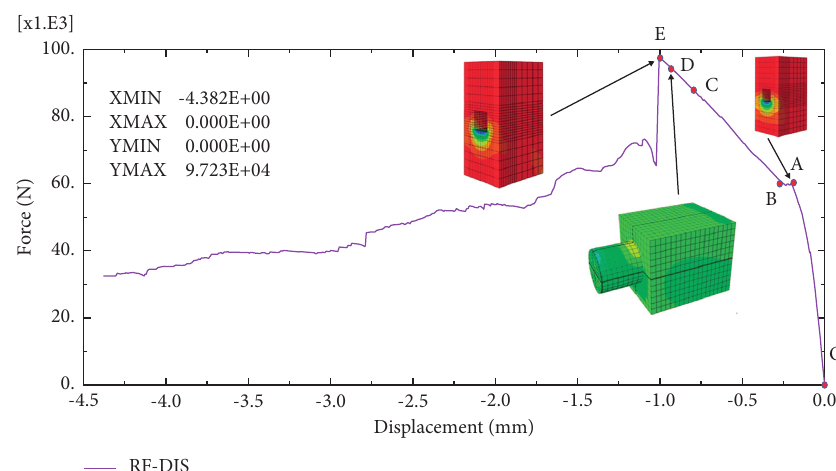
Figure 15: Mechanical behavior of steel shear key joint in construction state.